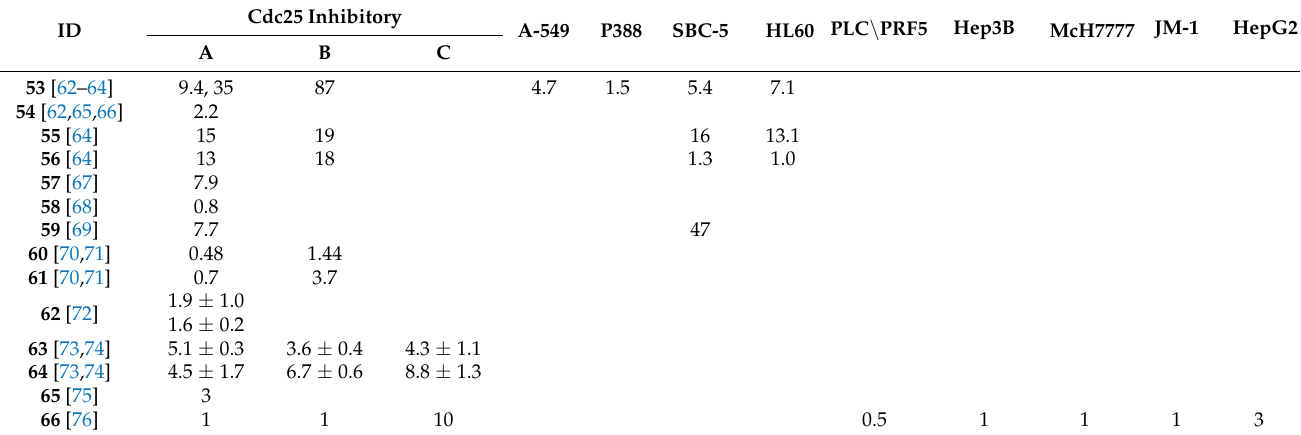
Table 4. Cdc25 inhibitors based on steroid and dysidolide-like compounds.